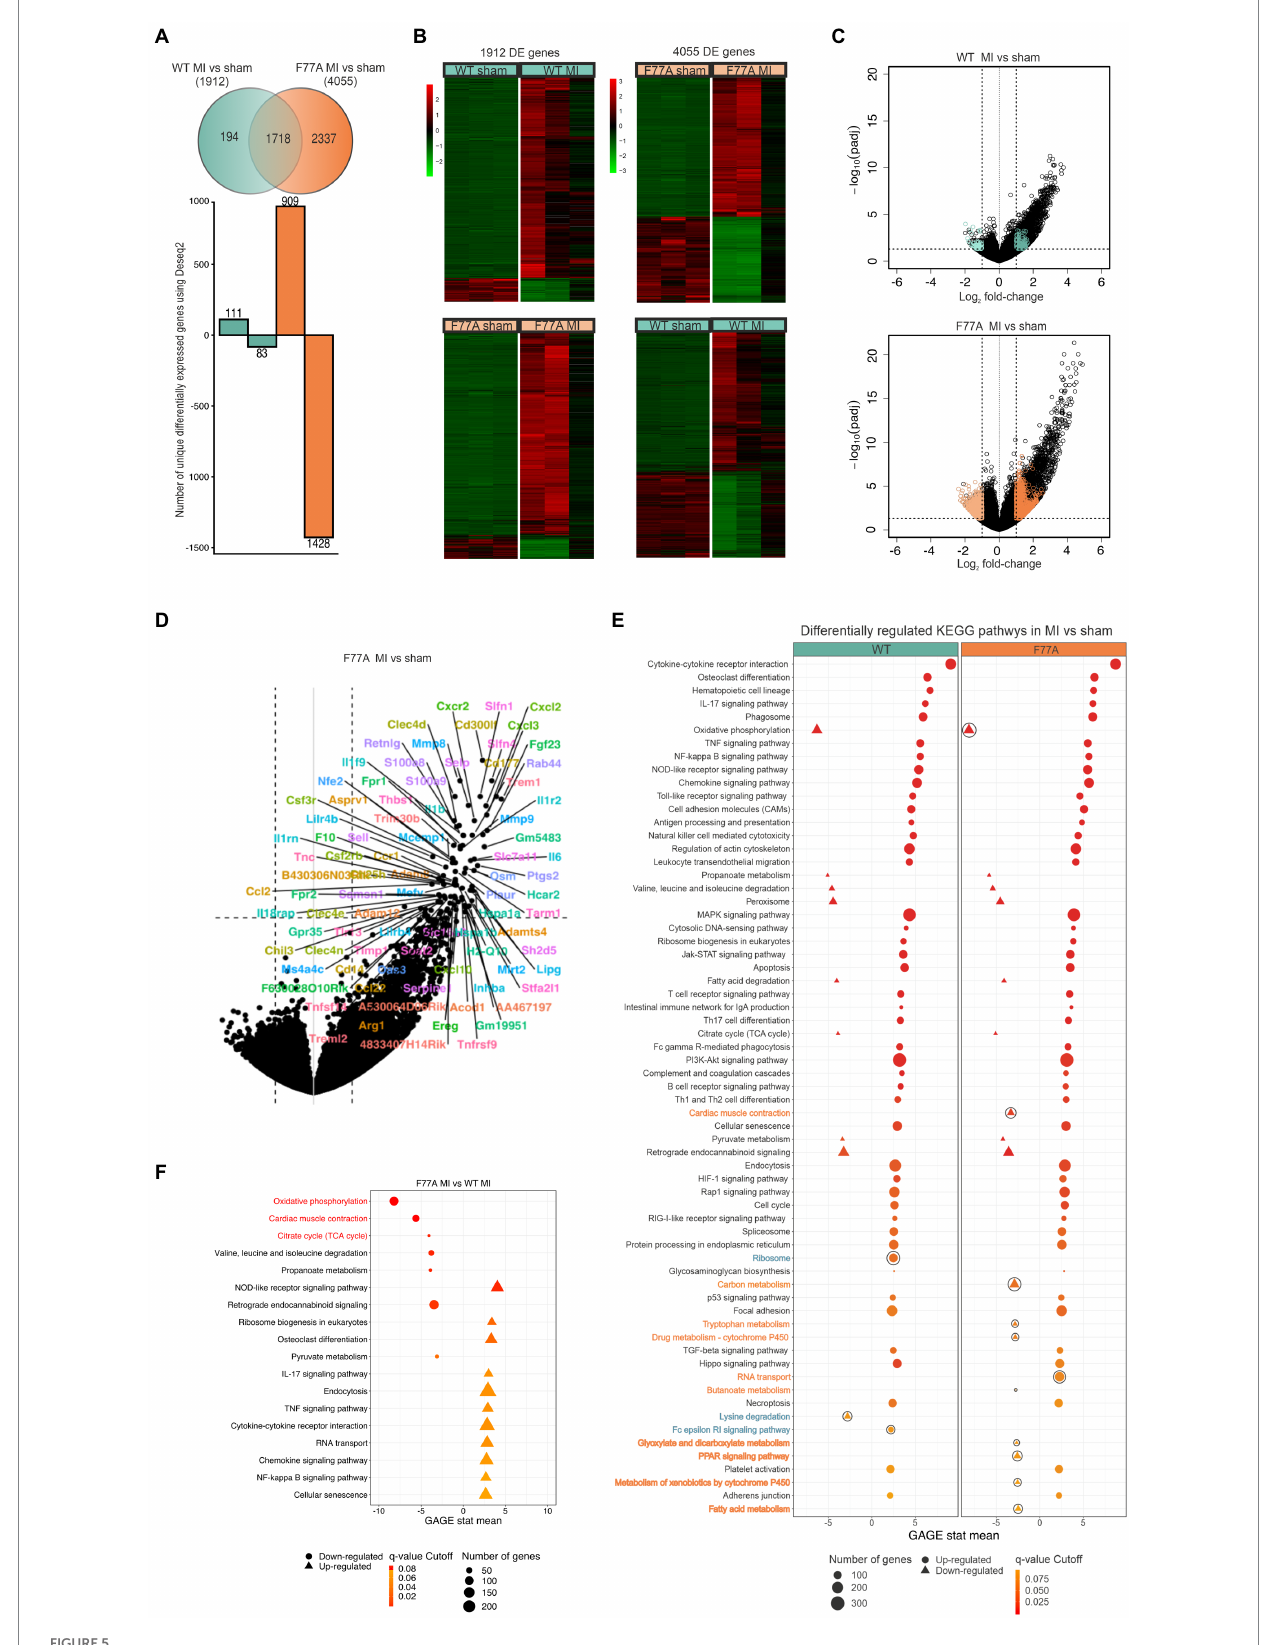
FIGURE 5 Higher number of differentially regulated genes in STAT1 F77A/F77A mice following LAD ligation compared to WT mice. (A) Venn diagram showing the number of unique genes that are upregulated or downregulated in WT and transgenic mice ( n = 12, for each group 3 mice) 24 h after LAD ligation.